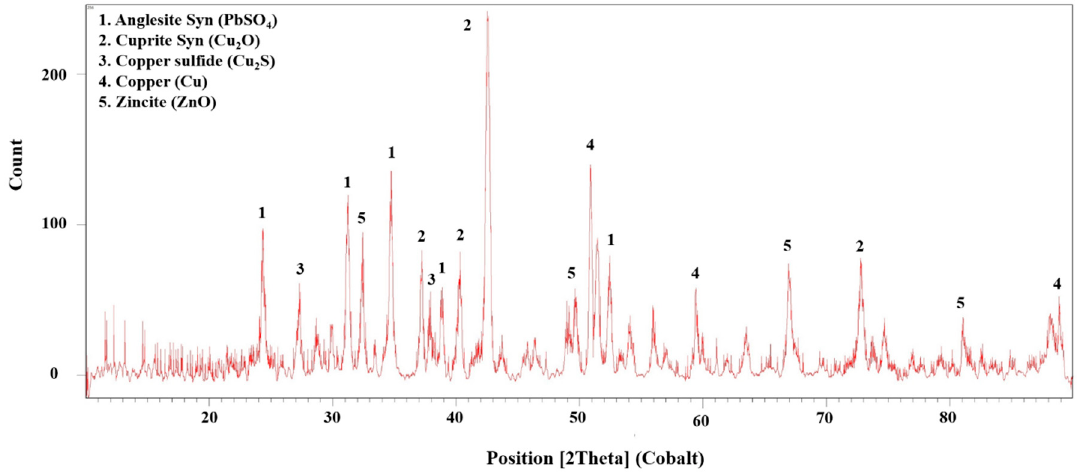
Figure 2. XRD di ff ractogram of copper smelter flue dust. Figure 2. XRD diffractogram of copper smelter flue dust.